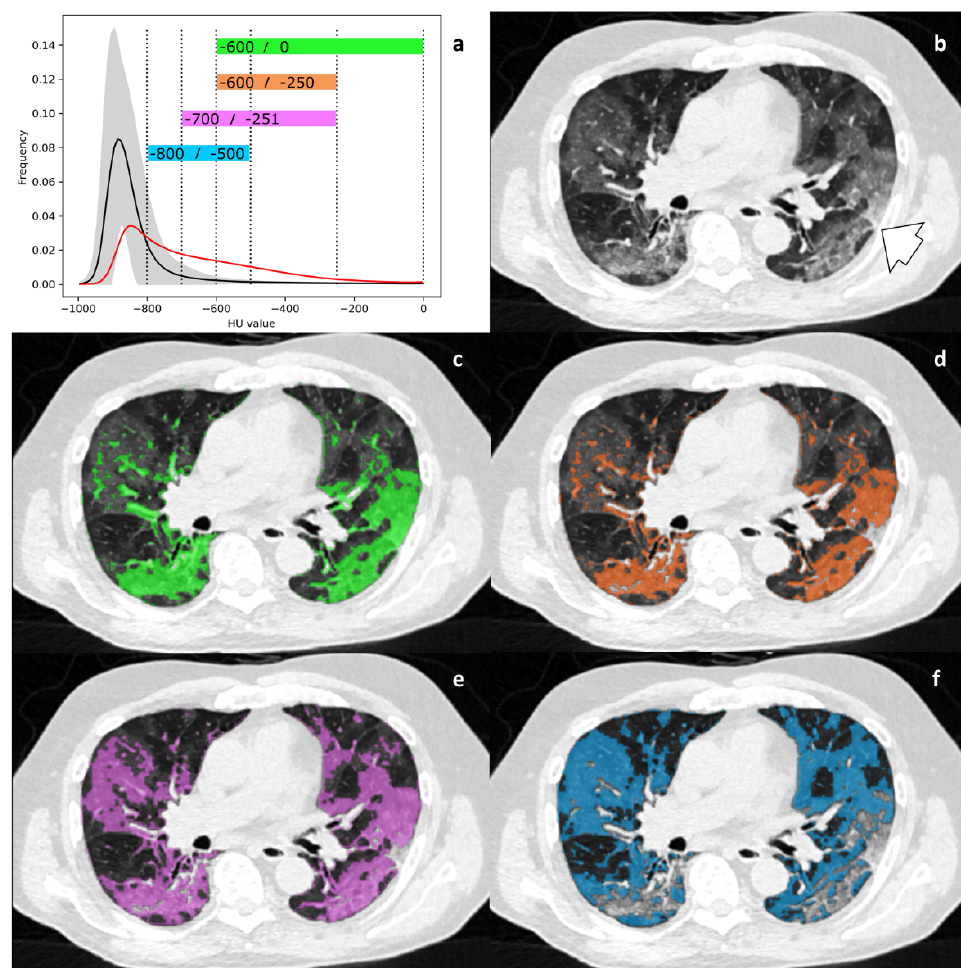
Figure 3. ( a – f ). Mean histogram and HU thresholds. Mean histogram curve of the healthy control group with all analyzed HU thresholds (a; dotted lines; black line = mean, grey area = 2 SD). The red curve indicates the histogram of a 75-year-old patient with diagnosed COVID-19. Note the overlap with the mean histogram curve of the healthy lung group below − 750 HU. Within the range of − 750 to − 600 HU, HAA in healthy lungs start to diminish, whereas in this representative case of AP, HAA remains high. Best discriminatory power is seen in HAA-600/-250 and HAA-600/0, respectively, as HAA in AP is high and HAA in healthy lungs approaches zero. Figure 3b shows the corresponding chest CT. Bilateral and peripheral GGO is noted, but so is subtle consolidation in the posterior segment of the right upper lobe (arrow). Four HU threshold-derived HAAs (colored boxes in Figure 3a) are shown as overlays in Figure 3c–f. GGOs and consolidations are included according to their density. HAA − 800/ − 500 only captures mild GGOs; HAA-600/0 also includes denser consolidation. Abbreviations: AP = atypical pneumonia. HAA = high attenuation area. GGO = ground glass opacity. SD = standard deviation.